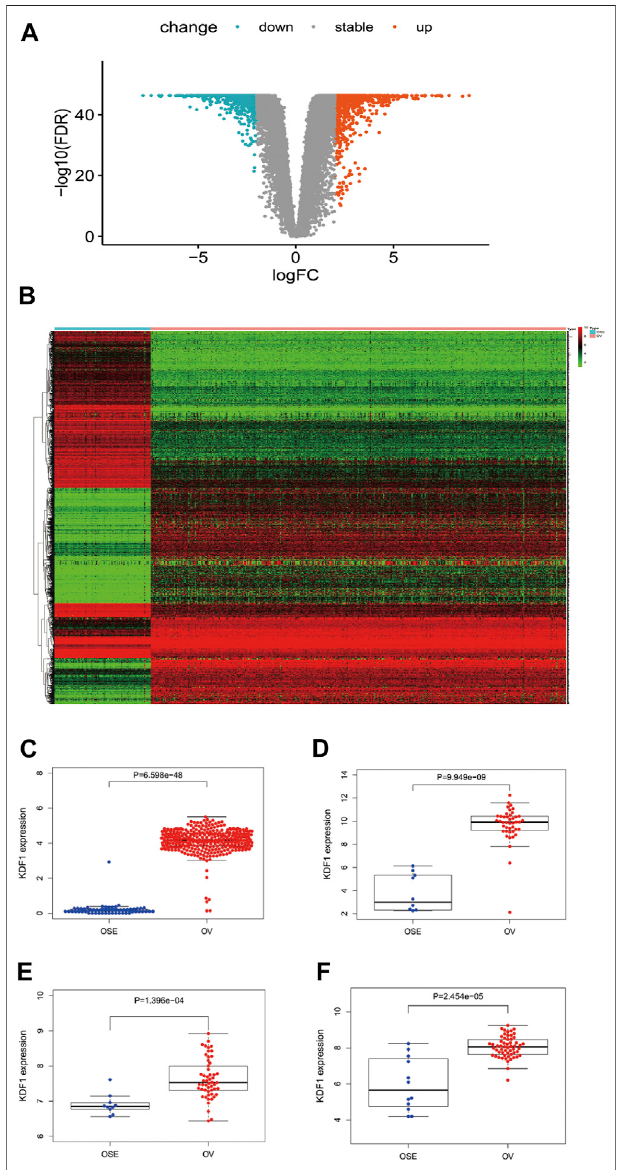
FIGURE 1 | Resultof differentiallyexpressed gene analysis. The volcano plot of differentially expressed RNAs in ovarian cancer (A) . Heatmap of all differentially expressed genes in ovarian cancer (B) . Relationship of expression levels of KDF1 in ovarian cancer tissues and normal ovarian tissues in TCGA (C) . Relationship of expression levels of KDF1 in ovarian cancer tissues and normal ovarian tissues was validated by datasets